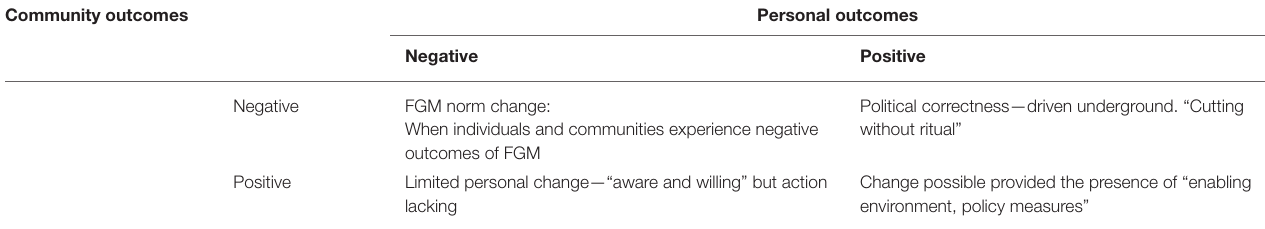
TABLE 2 | Role of rewards and sanctions on